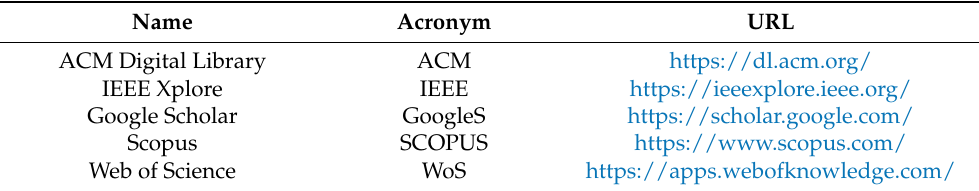
Table 1. Databases used in the search (access date 19 May